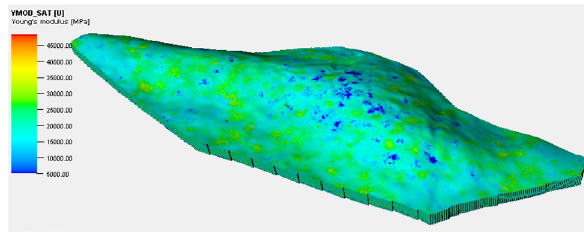
Fig. 14 Longitudinal discretization of minimum horizontal principal stress